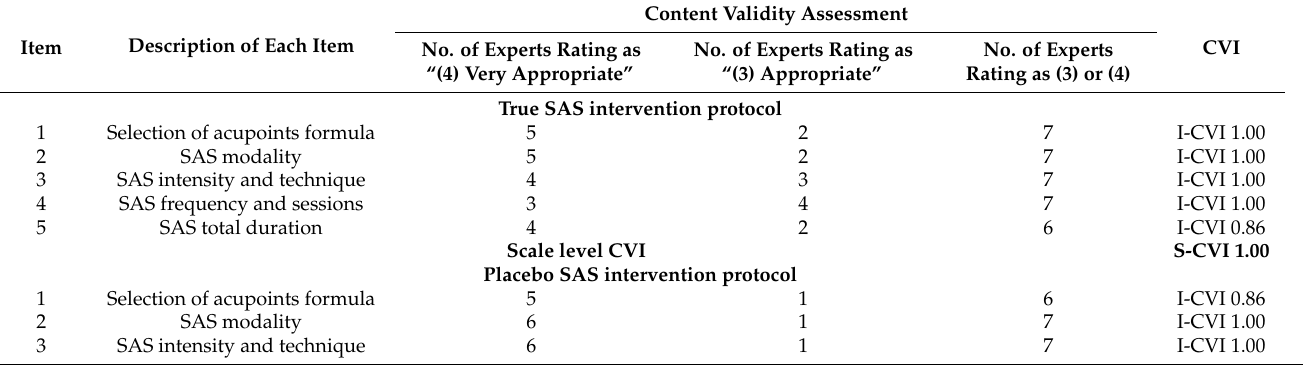
Table 3. Content validity assessment of the true and placebo SAS protocol (number of experts =